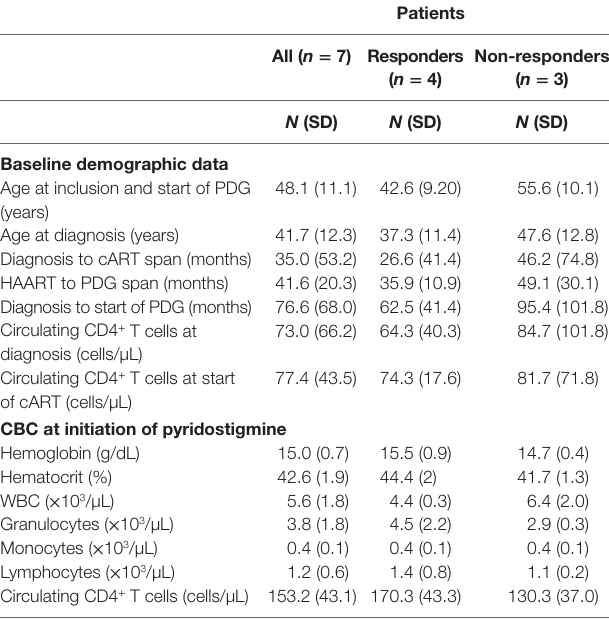
TaBlE 1 | Baseline characteristics of participants according to response